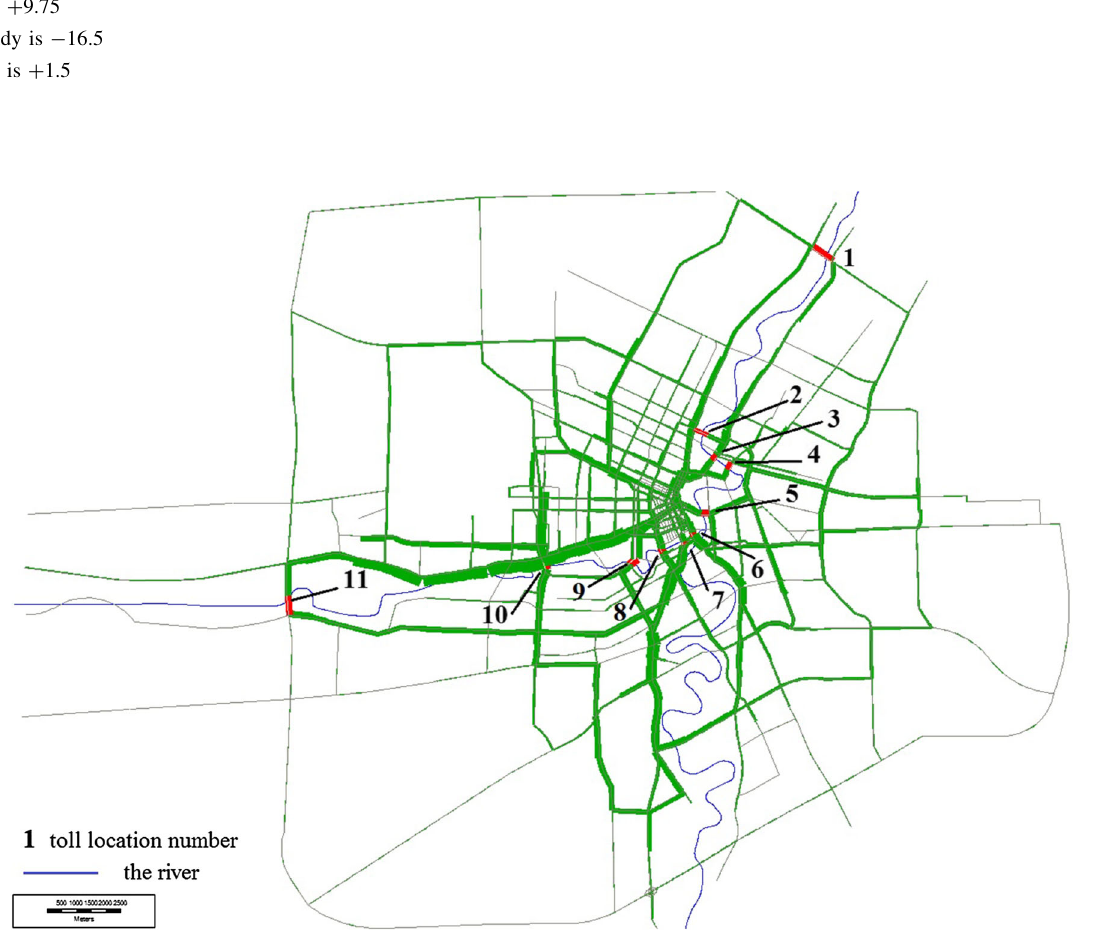
Figure 3d: Road 1 is subsidized for target value of 3.5 and road 5 is tolled for target value of